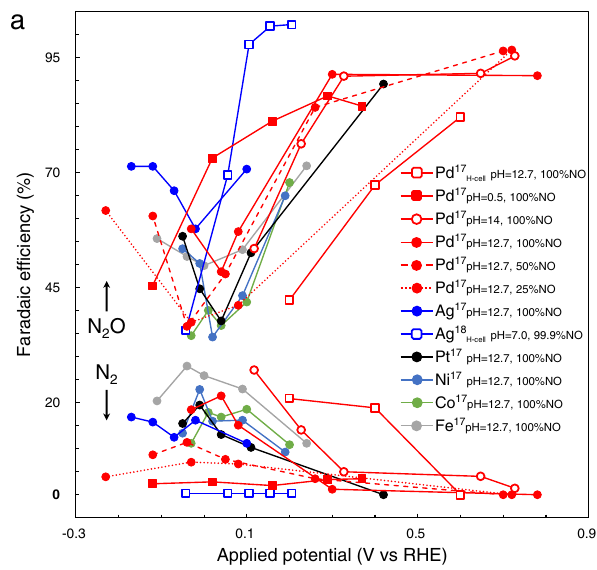
Most data points were measured in a fl ow-cell, while the open square symbols are detected values in a batch-type cell (H-cell). The data points for N 2 , N 2 O, and NH 3 from the same experimental conditions were connected,